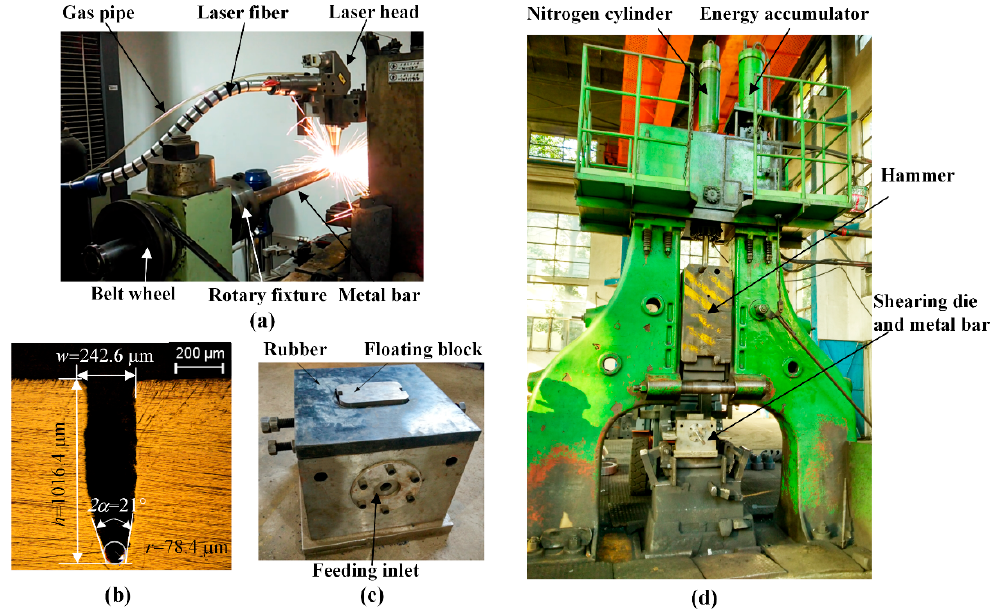
Figure 3. The experimental equipment. ( a ) Laser rotary cutting system. ( b ) Kerf shape for the shearing tests. ( c ) Double-shearing die. ( d ) 35 kJ electro-hydraulic power-drop hammer.